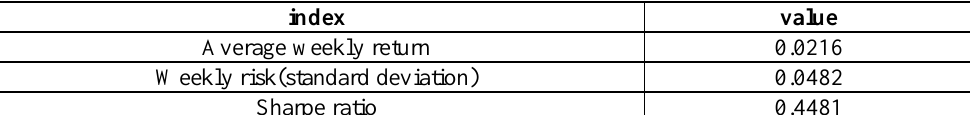
Table 7. Weight parity portfolio performance on test data